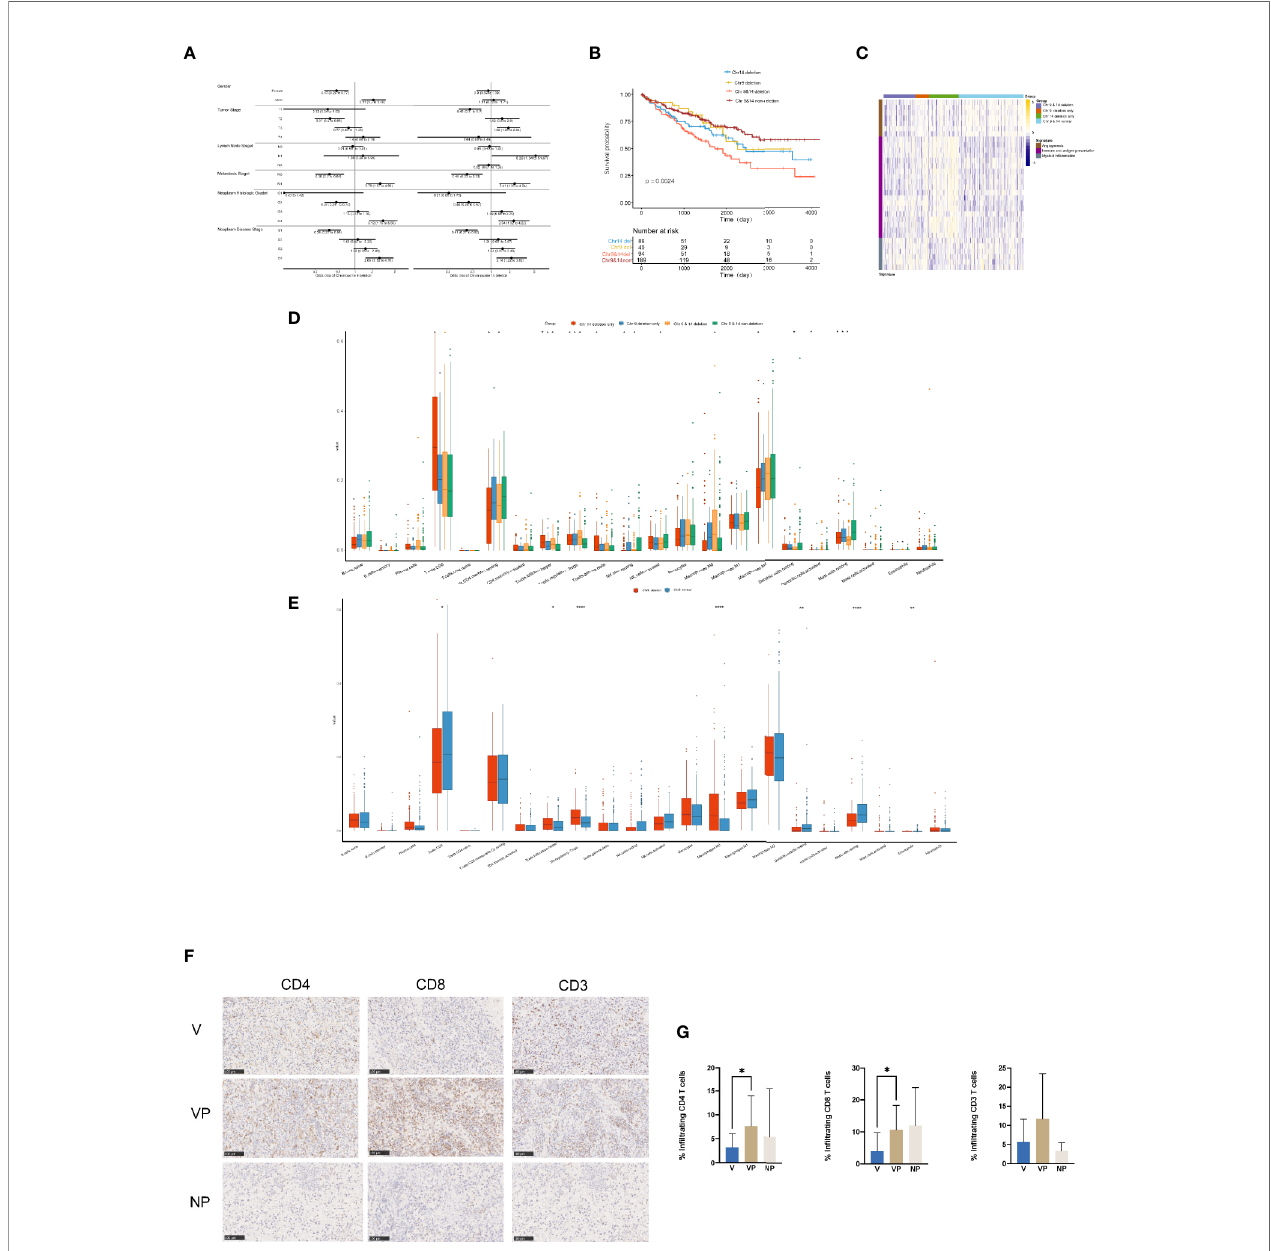
FIGURE 6 | Clinical features and tumor microenvironment of the ccRCC patients with deletions in chromosomes 9 and 14 based on the KIRC database. (A) Clinical features of the ccRCC patients in the KIRC database with or without deletions in chromosome 9 (left) or 14 (right). (B) Kaplan – Meier curves for OS of ccRCC patients in the KIRC database with or without chromosome 9 and/or 14 deletions. (C) Heat map of gene expression signatures in angiogenesis, immune and antigen presentation and myeloid in fl ammation of ccRCC patients in the KIRC database with or without chromosome 9 and/or 14 deletion. (D) Analysis of tumor-in fi ltrating immune cell types in ccRCC patients in the KIRC database with or without chromosome 9 and/or 14 deletion. (E) Analysis of tumor-in fi ltrating immune cell types in ccRCC patients in the KIRC database with or without deletions in chromosome 9. Immunostaining (F) and analysis (G) for CD4, CD8 and CD3 in the V, VP, and NP groups. (G) * p < 0.05; ** p < 0.01; *** p < 0.001. ccRCC, clear cell renal cell carcinoma; KIRC, kidney renal clear cell carcinoma; OS, overall survival; V, VTT; VP, VTT matched primary tumor; NP, normal primary tumors without